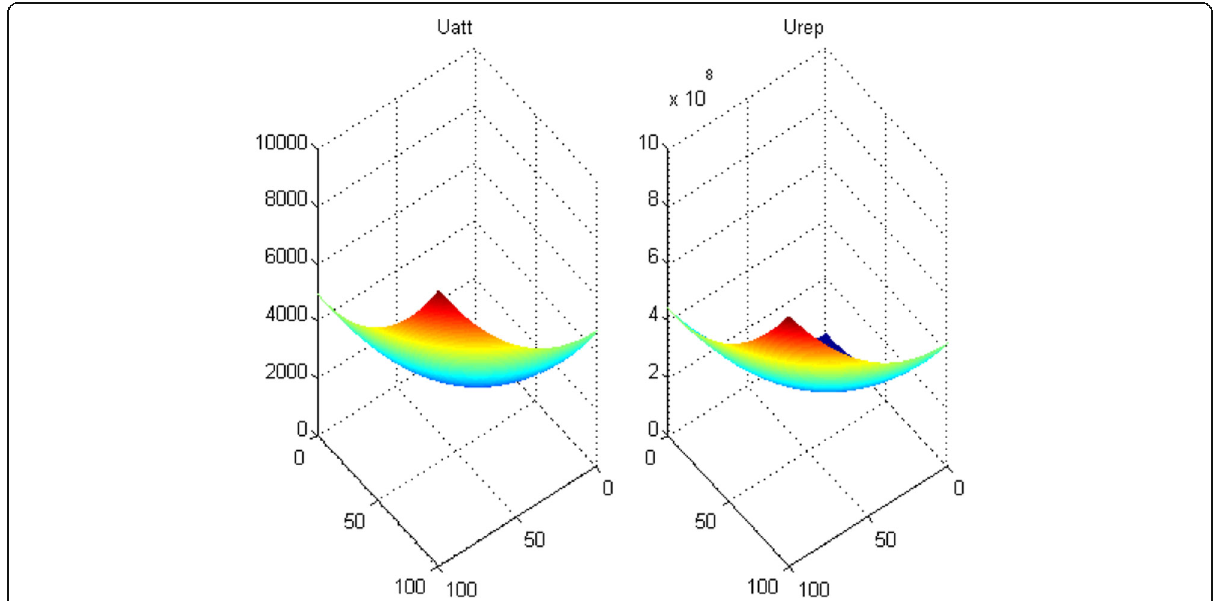
Fig. 13 Mesh plot of the potential energy of attraction and repulsion in the modified artificial potential field algorithm for circular obstacles with radius R = 0.18